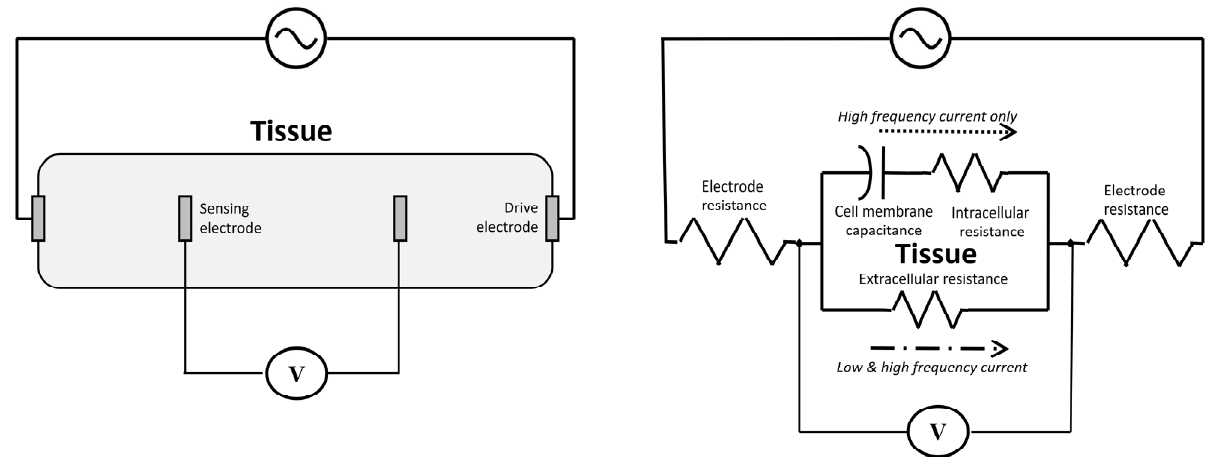
Figure 3. Tetrapolar measurement of tissue impedance ( left ); and equivalent electric circuit model ( right